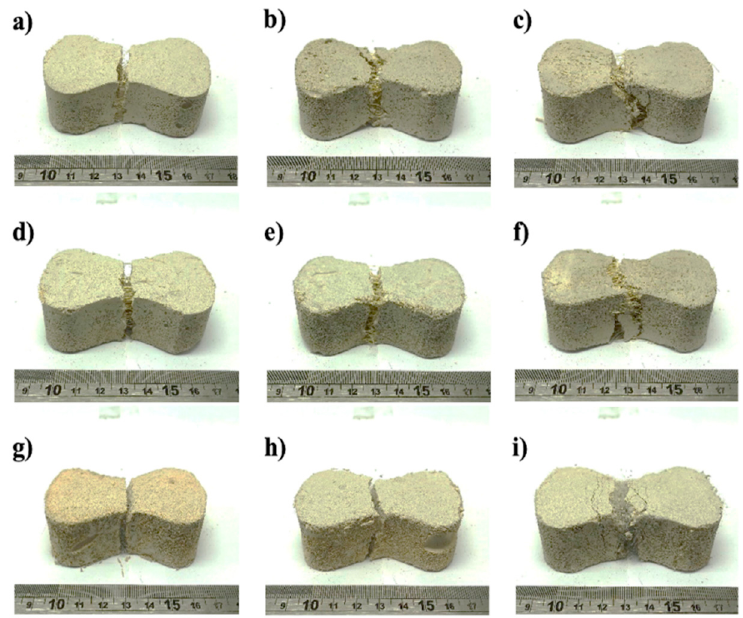
Figure 6. Representative foamed concrete specimens after the tensile test, reinforced with untreated henequen fiber: ( a ) H0.5FC; ( b ) H1.0FC and ( c ) H1.5FC; with treated henequen fiber: ( d ) HT0.5FC; ( e ) HT1.0FC and ( f ) HT1.5FC and with PP fiber: ( g ) PP0.5FC; ( h ) PP1.0FC and ( i ) PP1.5FC.